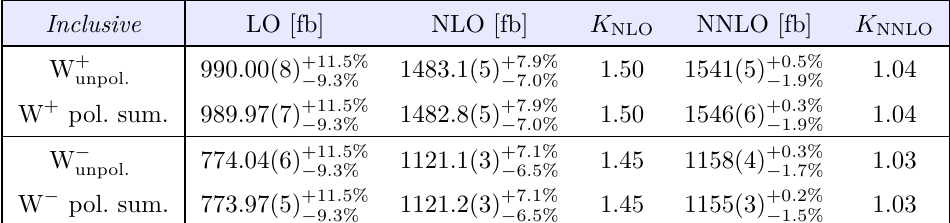
Table 3 . Total cross sections of pp → ‘ ± ( − ) ν ‘ j for the inclusive setup at the LHC with the centre- √ of-mass energy of s = 13 TeV. The unpolarised and polarised-sum predictions are provided at LO, NLO, and NNLO accuracy along with the corresponding K -factors. Numbers in parentheses indicate statistical errors while sub- and superscripts represent scale uncertainty.